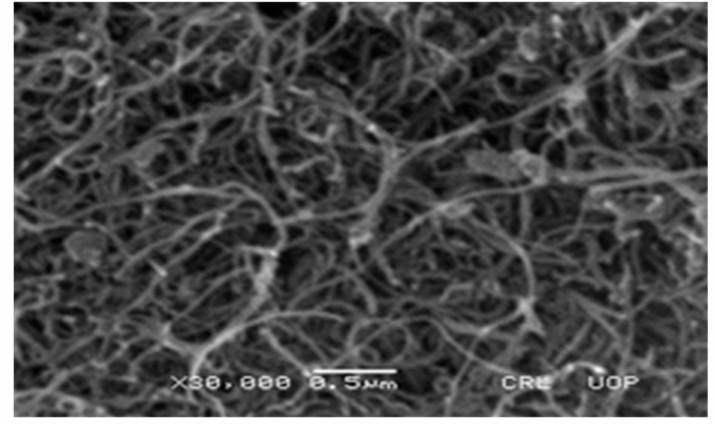
Figure 1. Scanning electron microscopy (SEM) image of Ag-Co/S nanoparticles.